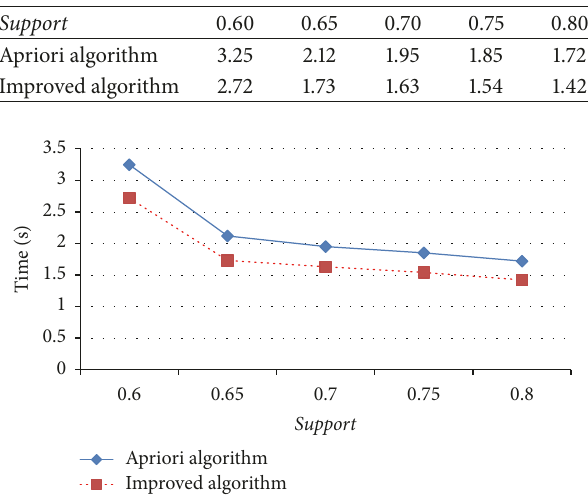
Table 3: Runtime of the two algorithms on mushroom dataset.